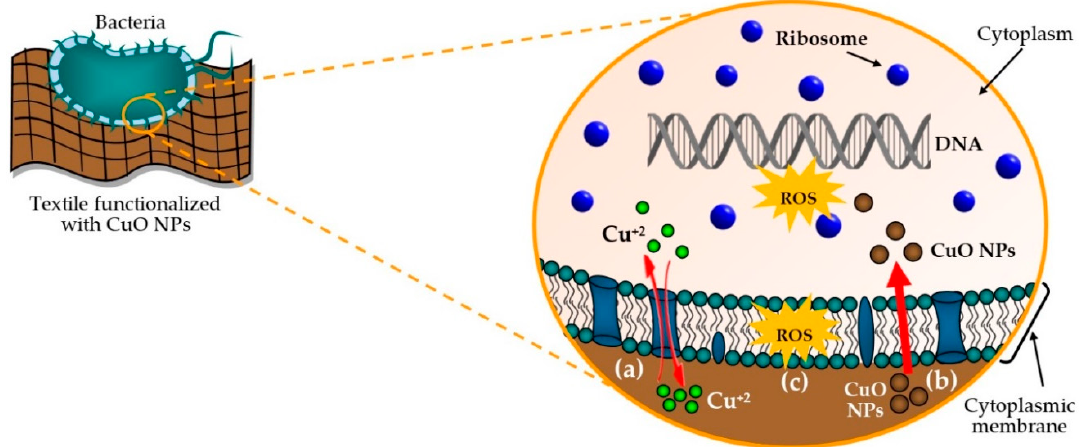
Figure 5. Diagram presentation of the mechanisms of the antimicrobial activity of textile materials functionalized with CuO NPs: (a) release of copper ions, (b) contact of CuO NPs with bacteria, and (c) reactive oxygen species.